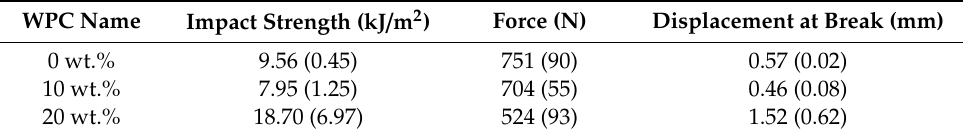
Table 2. Tensile ‐ impact strengths and their standard deviations in parentheses for all materials in a flood fed condition at 25 RPM.